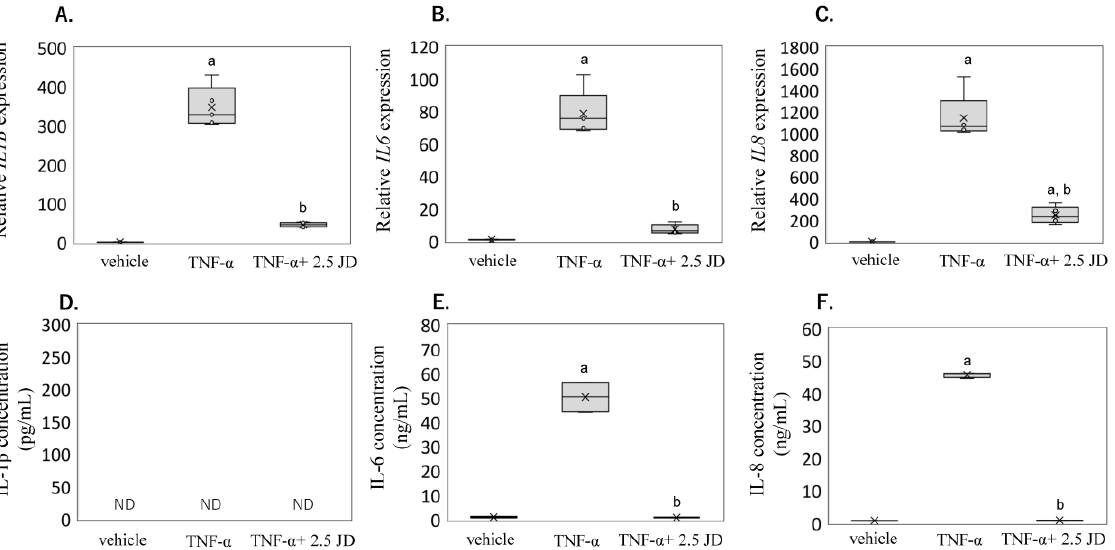
Figure 3. Effect of jietacin derivative on inflammatory cytokine expression and production in human primary synovial fibroblasts. IL1B ( A ), IL6 ( B ), IL8 ( C ) mRNA by qPCR, and IL-1 β ( D ), IL-6 ( E ), IL-8 ( F ) protein concentration by ELISA. Human primary synovial fibroblasts stimulated with DMEM (vehicle), TNF- α , or TNF- α + jietacin derivative. a p < 0.05 compared to vehicle, b p < 0.05 compared to TNF- α .